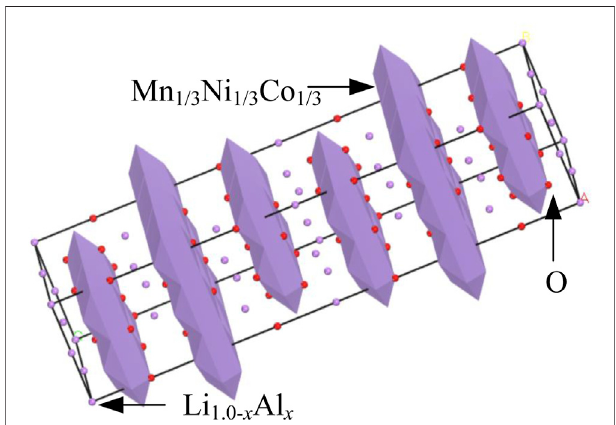
FIGURE 1 | The 2 × 2 × 2 supercell of Li 1.0- x Al x Ni 1/3 Co 1/3 Mn 1/3 O